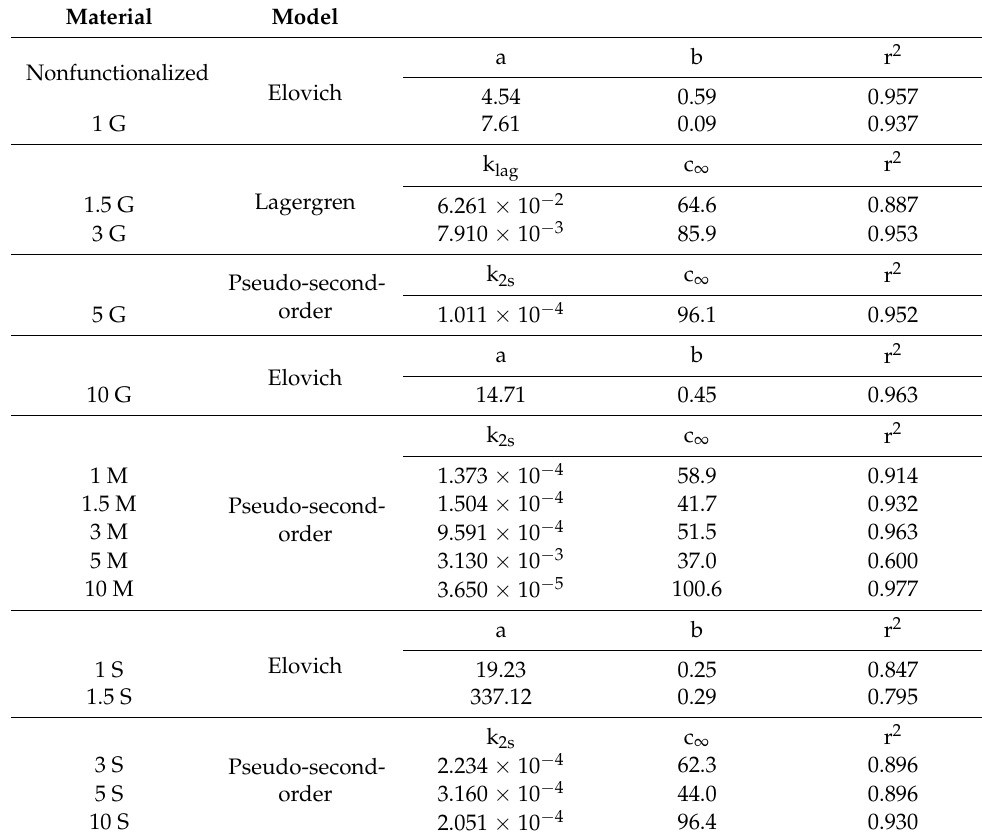
Table 2. Fitting constants and model applied to the absorption curves of the mesoporous materials.